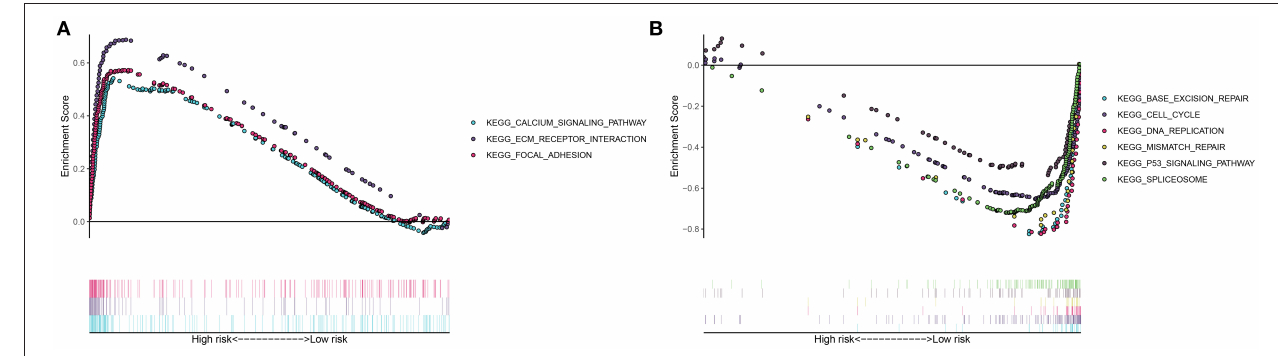
FIGURE 5 | Gene set enrichment analysis (GSEA) for signaling pathways involved in high- and low-risk groups. (A) Highly enriched pathways in high-risk gastric cancer samples. (B) Highly enriched pathways in low-risk